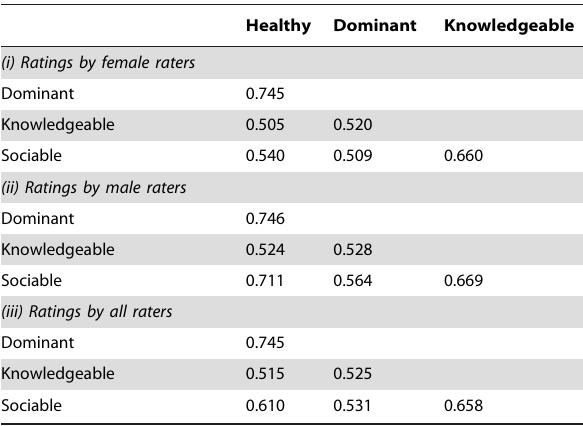
Table 2. Correlation between the ratings of different traits that were assessed by Tsimane’ raters from facial photographs of